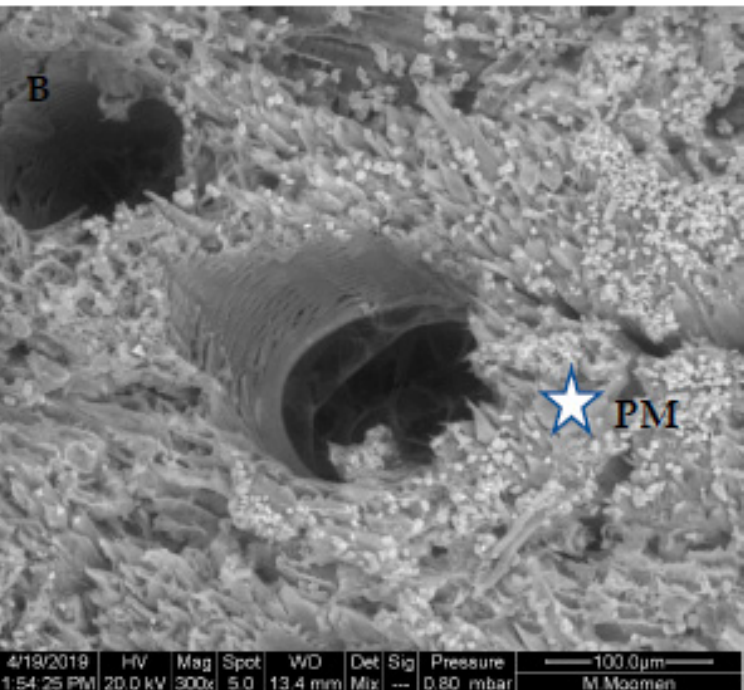
Figure 4. Diversities in crystal morphology and distribution in stem cross section of Sakasly cultivar. ( A ): abundance of crystals visualized on vascular system surface. Note the presence of numerous and rare crystal shape agglomerate in a ring-like shape (R) (arrow) and a drop like shape crystal (D) (arrow). ( B ): an enlarged view of a stem cross section which reveals the detail of an intact pit perforation or pit membrane (PM) marked with an asterix and the abundance of crystals around vessel elements (most of the mineral content is prismatic and spherical crystals).